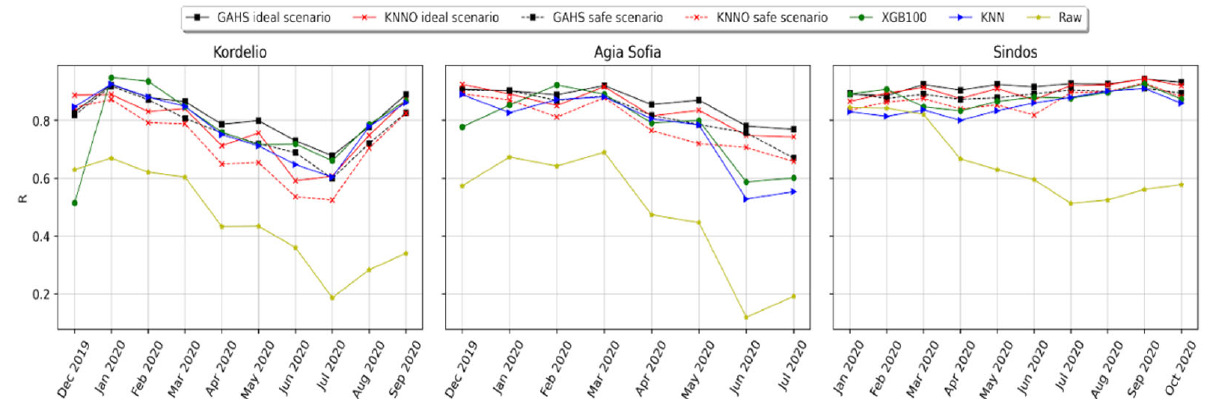
Figure 8. Comparison between the GAHS and SOL frameworks and the best performing batch models in terms of Pearson correlation coefficient for O 3 . The correlation coefficient between raw and reference measurements is also depicted.